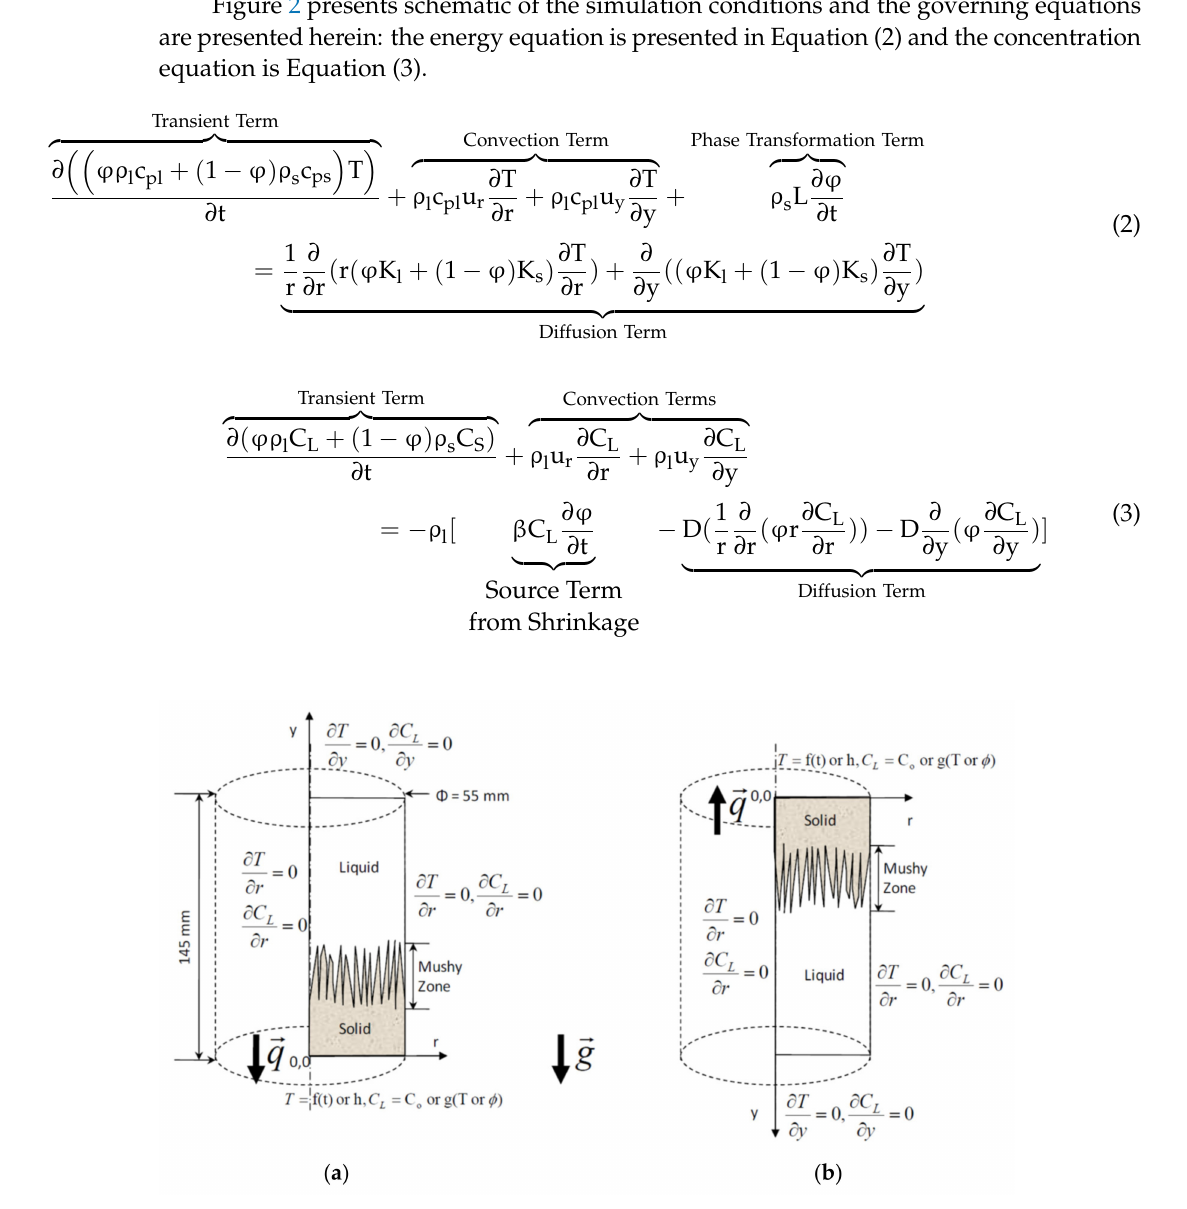
Figure 2. Schematic and boundary conditions for C L and T during the solidification simulations. ( a ) upward solidification and ( b ) downward